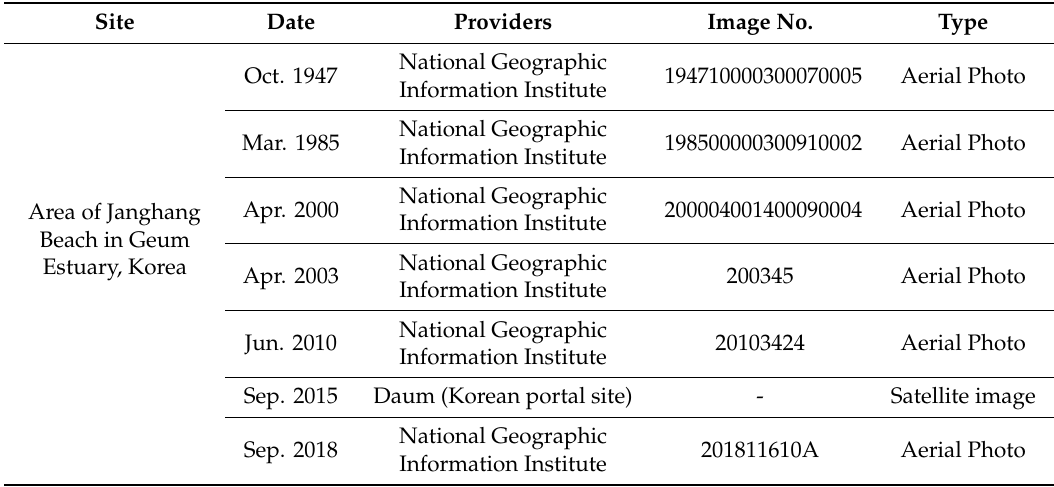
Table 6. Aerial and satellite imagery information.